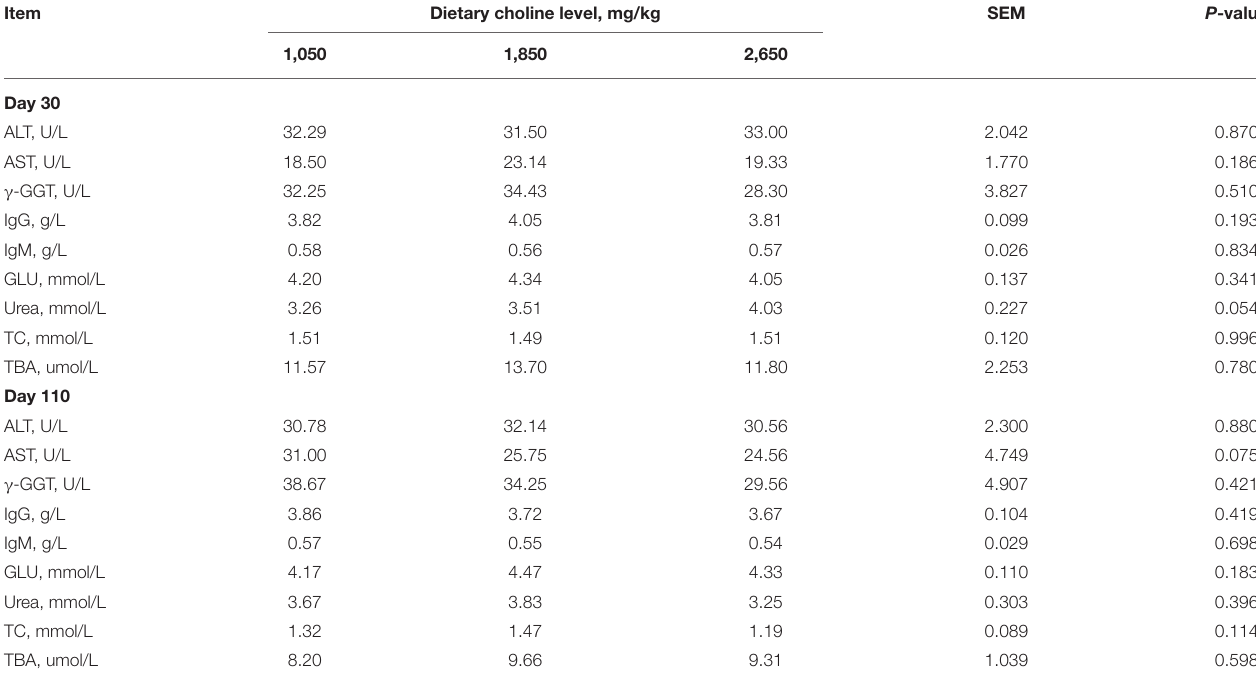
TABLE 5 | Effect of dietary choline levels during gestation on plasma biochemical profiles of sows. Item Dietary choline level, mg/kg SEM P